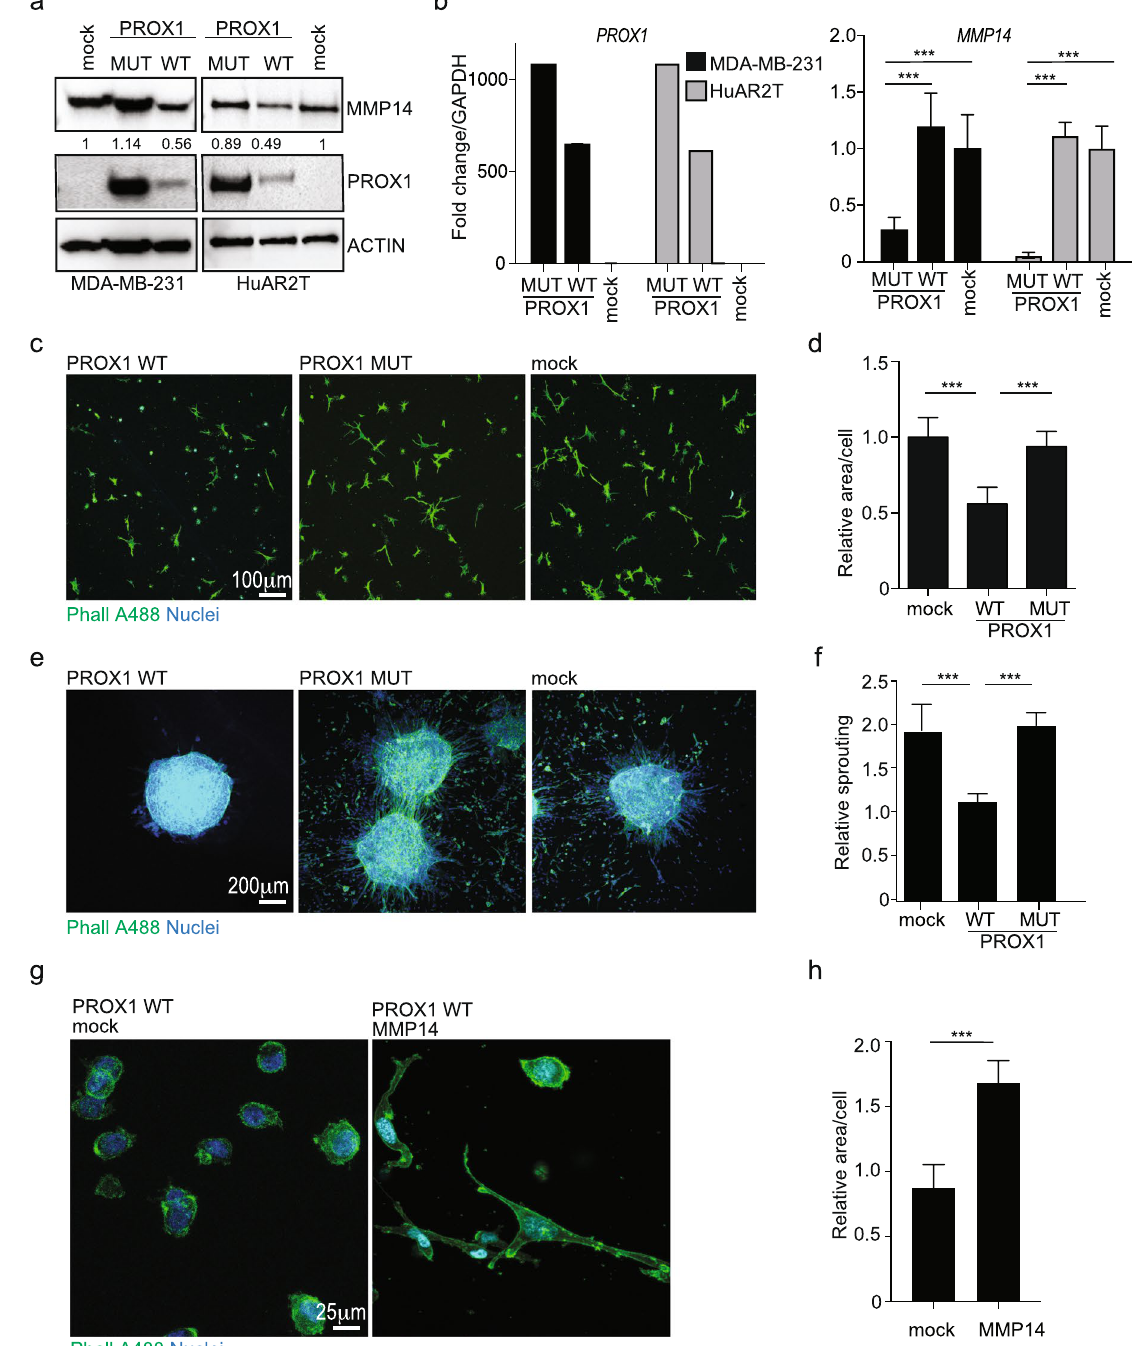
Figure 5. PROX1 reintroduction decreases MMP14 expression and reduces 3D invasiveness in BEC and cancer cells. ( a ) MDA-MB-231 and HuAR2T were treated with the indicated siRNAs for 72 h, and whole cell extracts were analysed by immunoblotting for the indicated proteins using actin as a loading control; numbers indicate the intensity of MMP14 band for each sample normalized to the corresponding loading control. Cropped membranes are shown, uncropped membranes can be found in Fig. S3e,f. ( b ) The samples in ( a ) were analysed by RTqPCR for the indicated targets with GAPDH as an internal control. Bars represent the average of three independent experiments, error bars show SD. ( c ) 3D fibrin invasion assay with MDA-MB-231 transduced with lentiviruses expressing PROX1 WT or MUT and stained with Phalloidin (Phall A488) and Hoechst. Empty vector was used as a control (mock). Representative images are shown. ( d ) Quantification of three images per condition described in ( c ) from three independent experiments (n > 200 cells/condition). Bars represent the average area occupied by each cell and normalized to the mock infected cells. (e) 3D sprouting assay of HuAR2T spheroids, treated and stained as in ( c ). Representative images are shown. (f) Quantification of